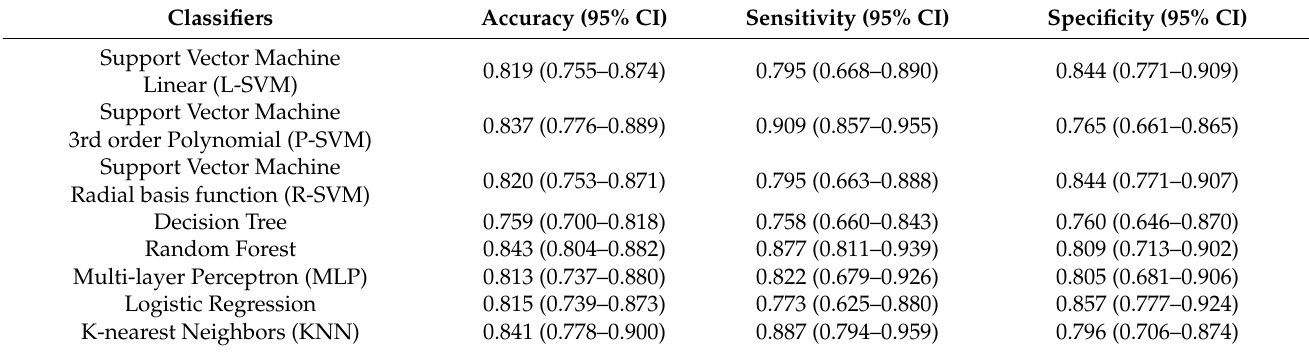
Table 5. Machine-learning results for EP dataset.